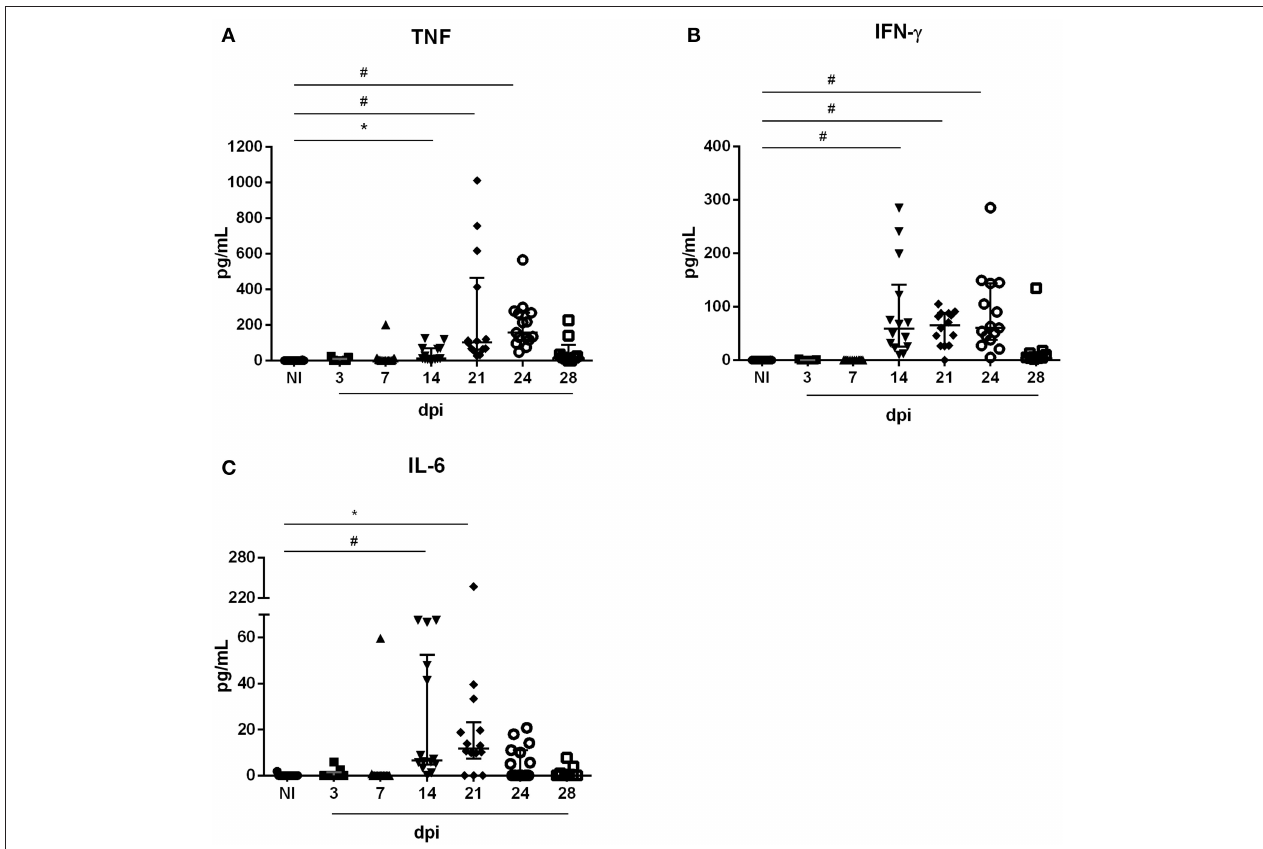
FIGURE 2 | Serum cytokine levels during oral acute T. cruzi infection. Male BALB/c mice were infected with 5 × 10 4 insect-derived metacyclic forms of T. cruzi within the oral cavity. In the course of the acute infection, serum was isolated and levels of TNF (A) , IFN- γ (B) , and IL-6 (C) were quantified in non-infected (NI) and infected mice by the CBA method. Values represent the median with interquartile range for each group/day post-infection and are representative of two independent experiments. Results were analyzed using Kruskal–Wallis with Dunn’s multiple comparisons test (*0.0001 < p < 0.05, # p < 0.0001). Significant differences not displayed in the graph: TNF: 3, 7 dpi 6= 21, 24 dpi; IFN- γ : 3, 7 dpi 6= 14, 21, 24 dpi; IL-6: 3 dpi 6= 14 dpi e 7 dpi 6= 14, 21 dpi. n: NI = 16; 3 e 28 dpi = 9; 7, 14 e 21 dpi = 14; 24 dpi = 15. n: NI = 16; 3 and 28 dpi = 9; 7, 14, and 21 dpi = 14; 24 dpi = 15.